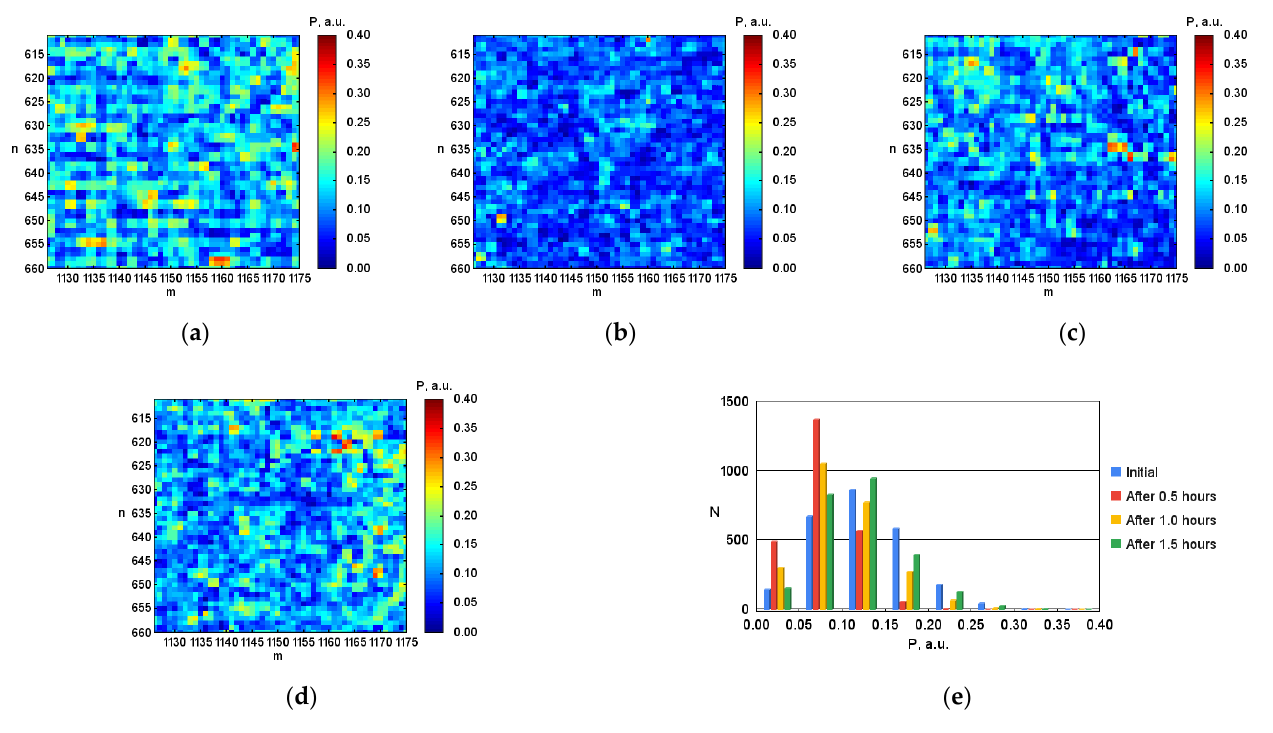
Figure 6. Coordinate distributions of the degree of polarization P , where: ( a ) is the initial hematocrit level; ( b ) is the hematocrit level after 0.5 h; ( c ) is after 1.0 h; ( d ) is after 1.5 h, and ( e ) the corresponding histograms of the object under investigation.